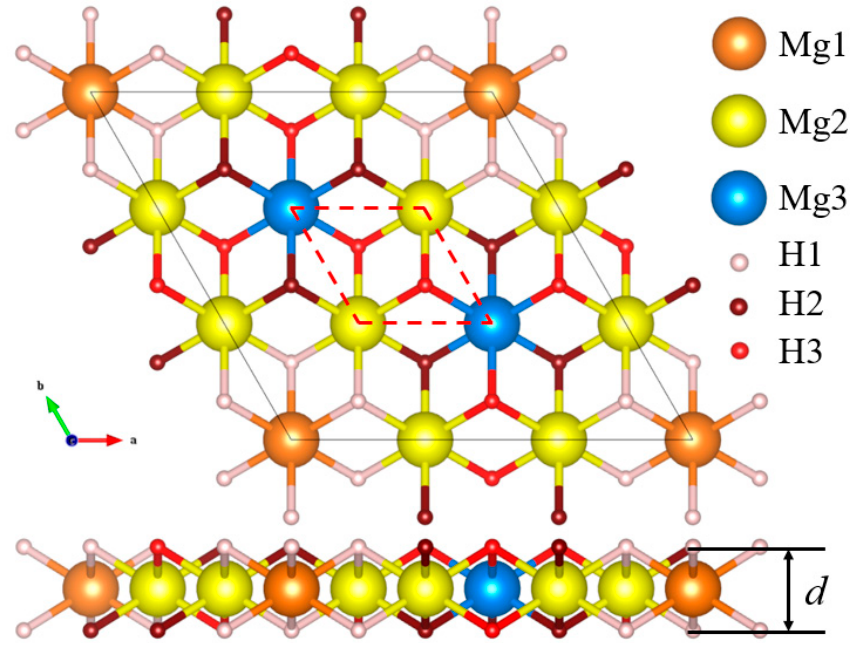
Figure 1. The relaxed unit cell of Mg 9 H 18 . The primate cell is marked with a red dashed box.